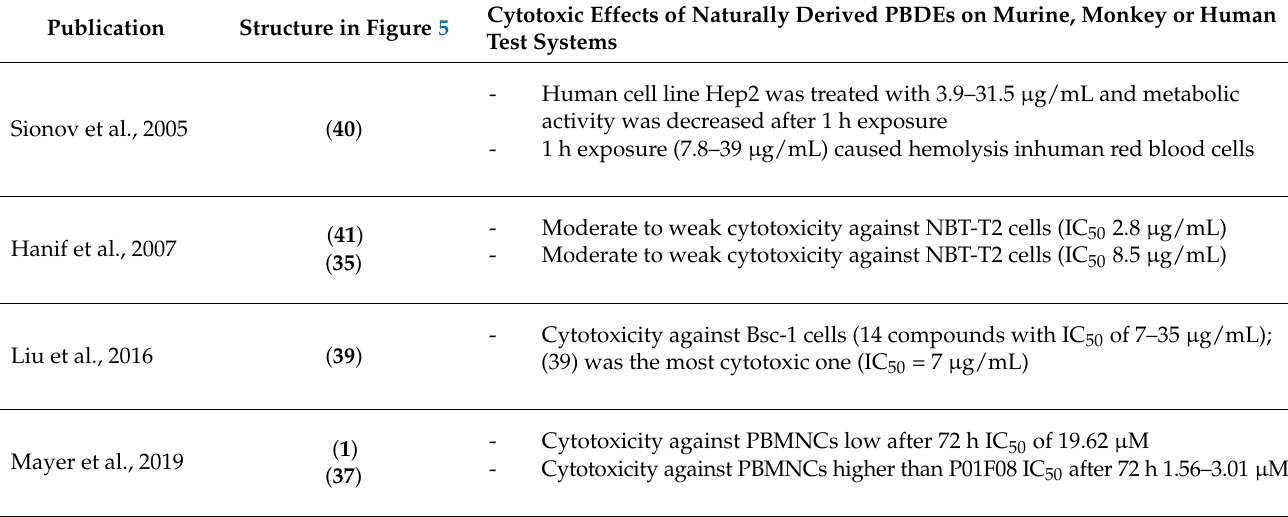
Table 3. Literature summary on bioactivity data of naturally derived and isolated PBDEs in relation to cytotoxicity on murine, monkey, or human cell lines. The literature on PBDEs was screened for data concerning bioactivity in murine, monkey, or human cell lines. The corresponding publication is listed together with most active compounds (structures are shown in Figure 5) and their respective biological